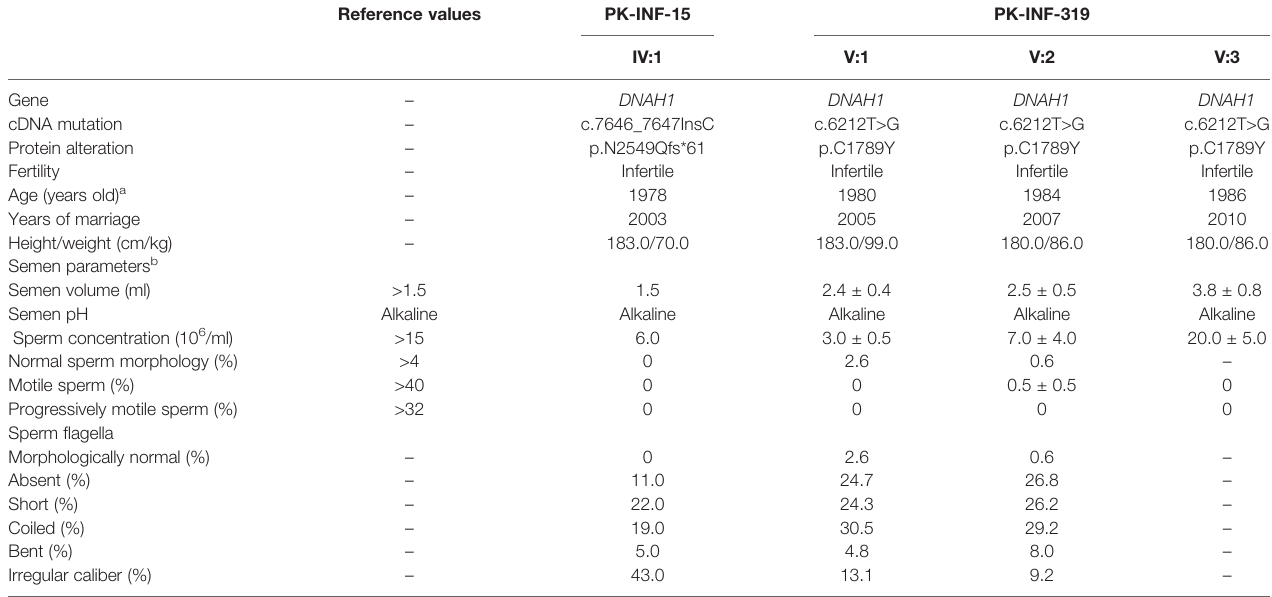
TABLE 1 | Clinical characteristics of